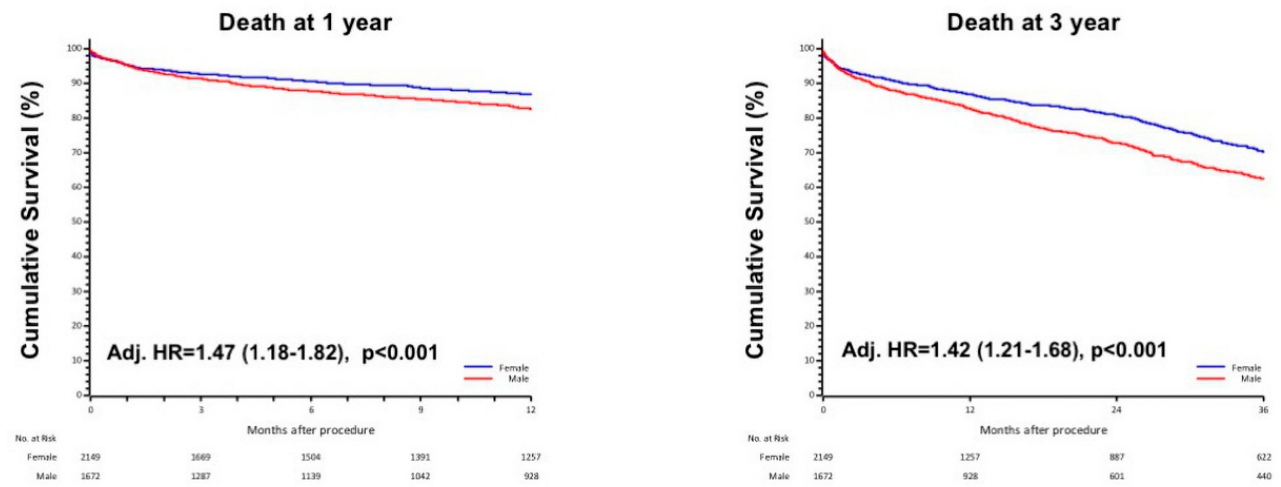
Figure 2. The 1-year and 3-year death in male and female, adjusted respectively for age, STS score, eGFR, diabetes and for age, STS score, eGFR, diabetes and severe COPD.